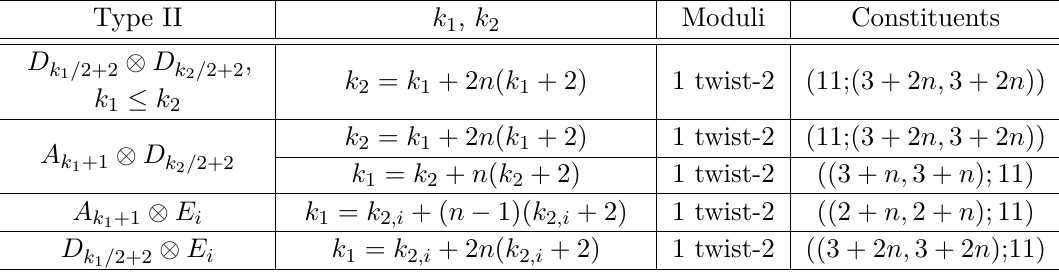
Table 3 . Overview of the different single-trace twisted operators for non-sparse theories. For i = 6 , 7 , 8 one has k 2 ,i = 10 , 16 , 28 . In all cases, n ∈ Z > 0 .